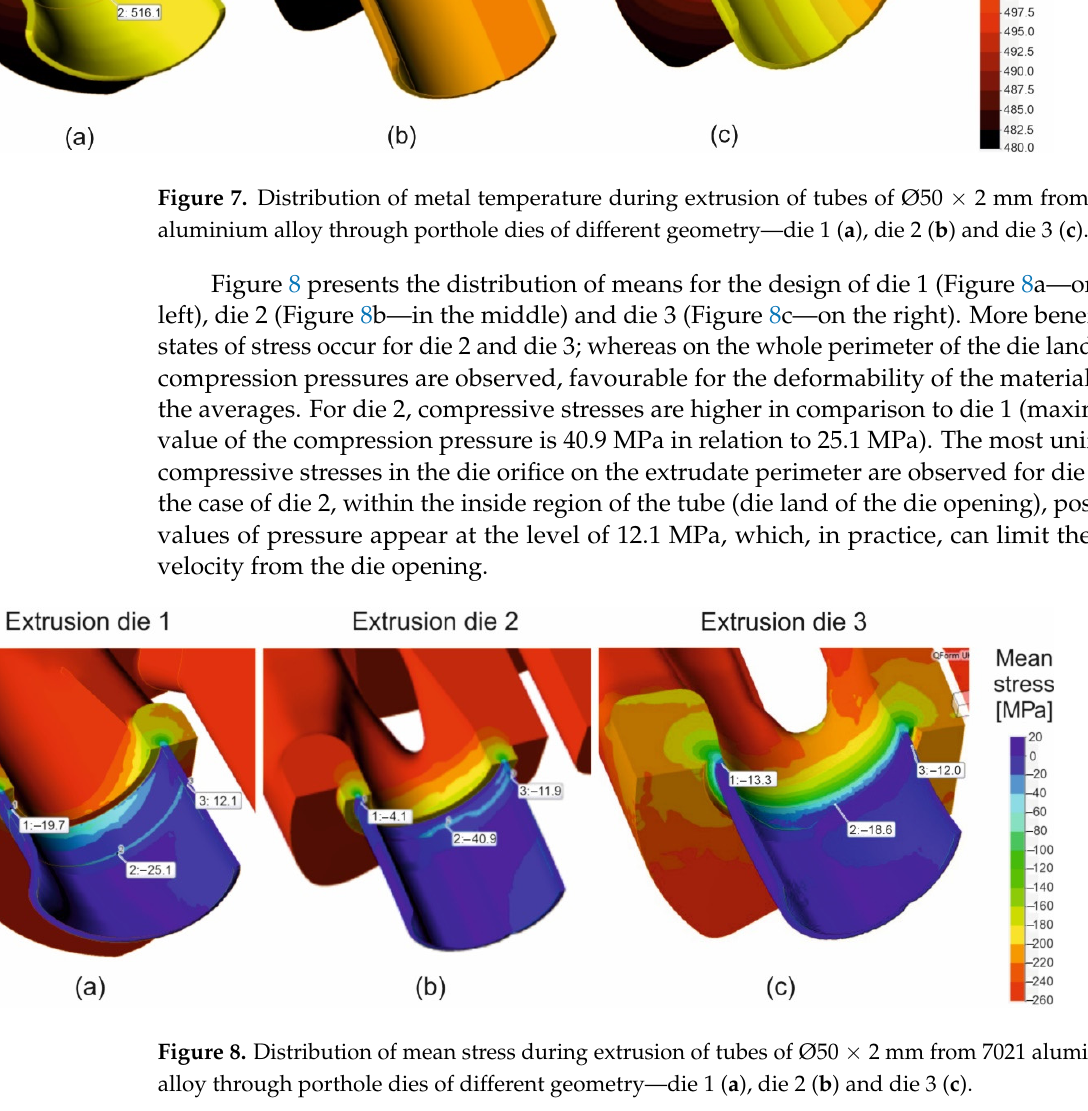
Figure 7. Distribution of metal temperature during extrusion of tubes of Ø50 × 2 mm from 7021 aluminium alloy through porthole dies of different geometry—die 1 ( a ), die 2 ( b ) and die 3 ( c ).